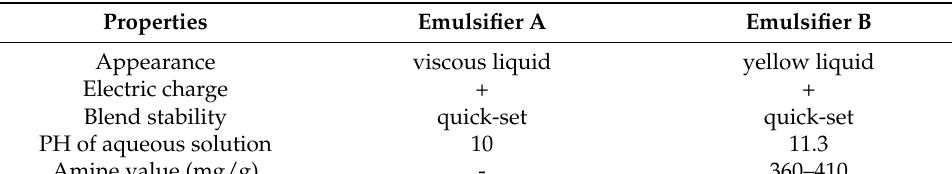
Table 2. Properties of emulsifier used in this study.